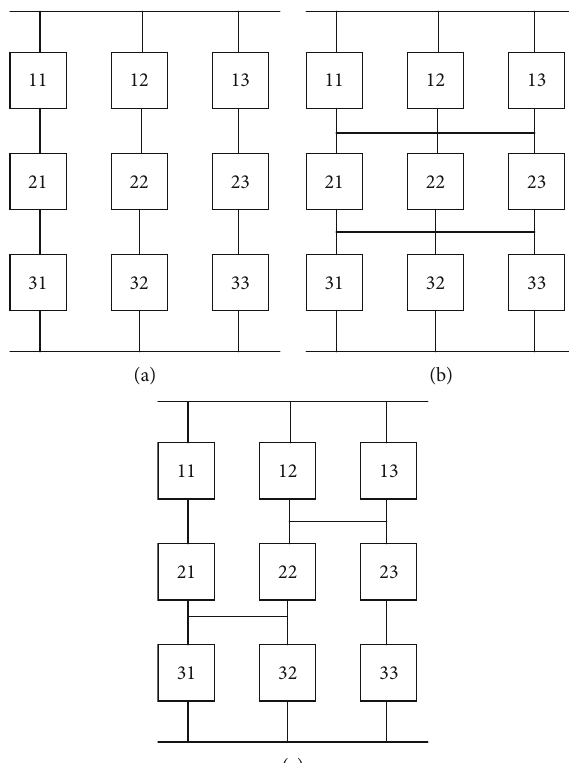
Figure 1: Various interconnection schemes: (a) SP array, (b) TCT array, and (c) BL array [7].